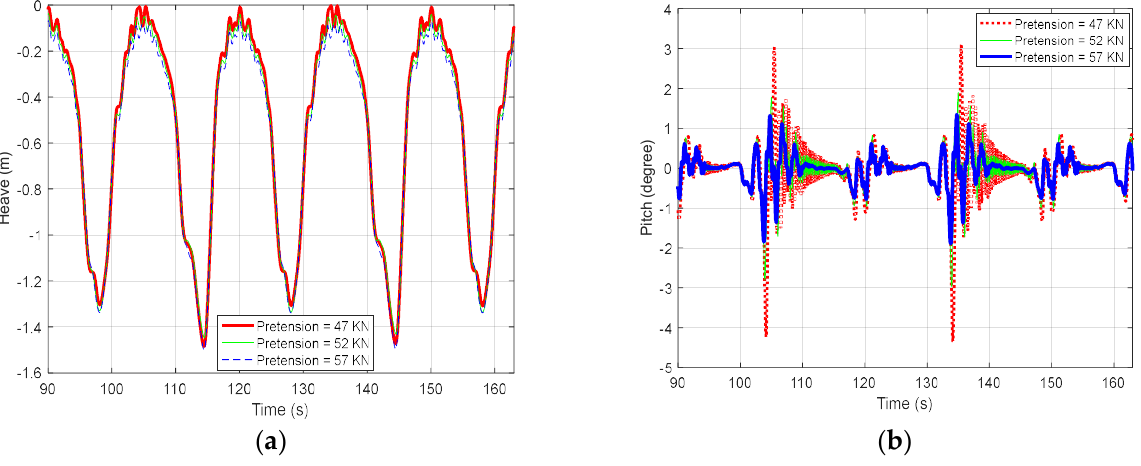
Figure 11. Out-of-plane motions with variations in pretension. ( a ) Heave time series, ( b ) pitch time series. Table 7. Comparison of 6 DOF motions of foundations with different pretension